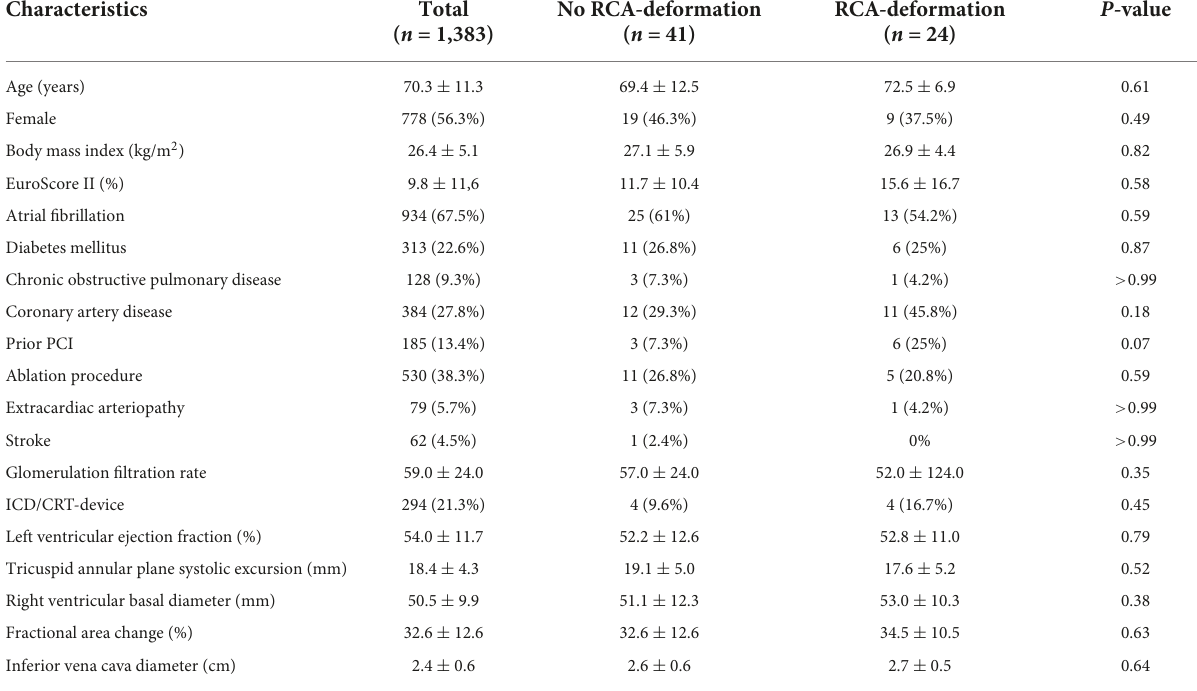
TABLE 1 Baseline characteristics of patients with and without affection of the right coronary artery.